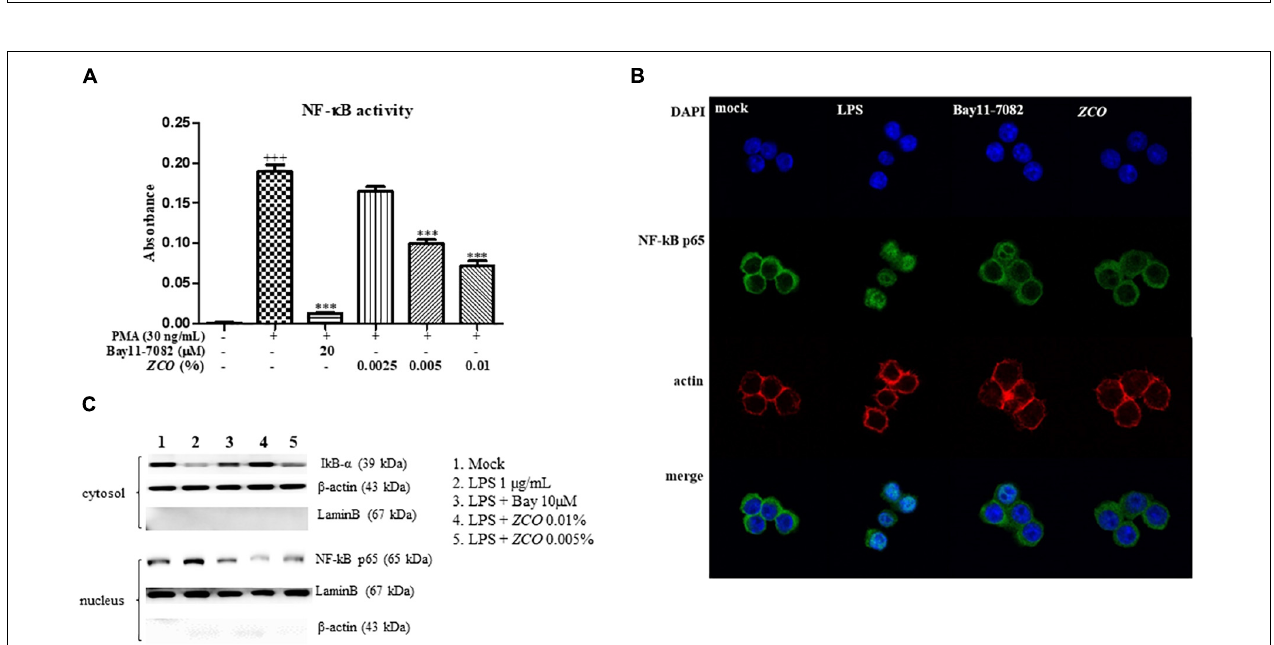
FIGURE 6 | Effect of ZCO on NF- κ B transcription and translocation. (A) Effect of ZCO on PMA-induced NF- κ B activation in 293T cells. 293T cells seeded into poly-D-lysine hydrobromide coated 96-well plate were transfected with a reporter plasmid, pNF- κ B-SEAP for 4 h. Cells were treated with ZCO (0.0025, 0.005, and 0.01%) or Bay11-7082 (20 µ M) for 2 h prior to stimulation with 3 ng/mL of PMA for 24 h. The supernatants were collected for NF- κ B activity assay. Experiments were conducted in quadruplicate and expressed as mean ± SEM ( ∗∗∗ P < 0.001 versus with PMA group). (B) Effect of ZCO on NF- κ B translocation into nucleus. RAW264.7 cells in 8-well glass chamber plate were pre-incubated with ZCO (0.01%) or Bay11-7082 (20 µ M) for 2 h prior to addition of LPS (1 µ g/mL). The cells were immunostained with a polyclonal anti- NF- κ B p65 antibody and Alexa Fluor 488-conjugated 2nd antibody. Bay 11-7082 was used as a control for the NF- κ B inhibitor. (C) Cytosolic and nuclear fractions were isolated from RAW264.7 cells. The protein level of NF- κ B p65 in the nuclear fractions and IkB- α in the cytosolic fractions were detected by Western blot analysis. +++ means the significance compared with the mock cells (deal with nothing).